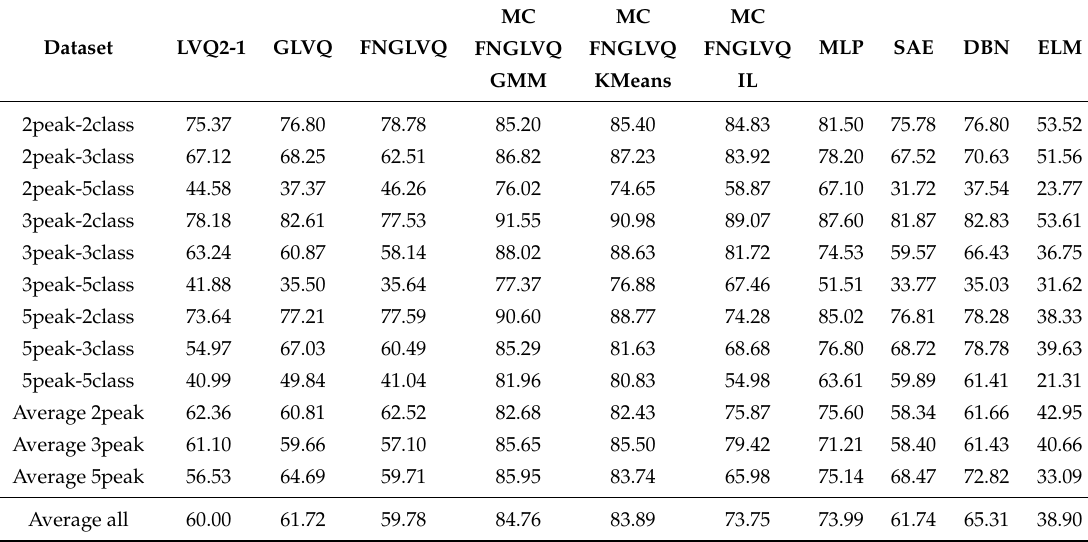
Table 3. Comparison on Synthetic